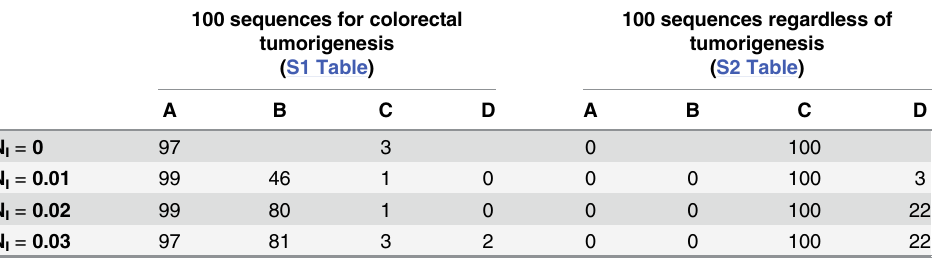
Table 1. The number of sequences for gene mutations that resulted in an M F greater than the M FTH . 100 sequences for colorectal tumorigenesis (S1 Table)